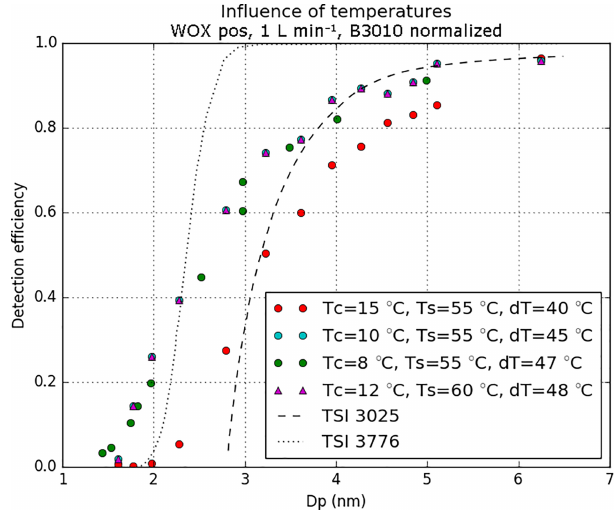
Figure 8. Influence of temperatures on detection efficiency of tung- sten oxide particles. The black lines are the typical curves of ul- trafine CPCs TSI 3025 ( D P 50 = 3 . 0nm) and TSI 3776 ( D P 50 = 2 .